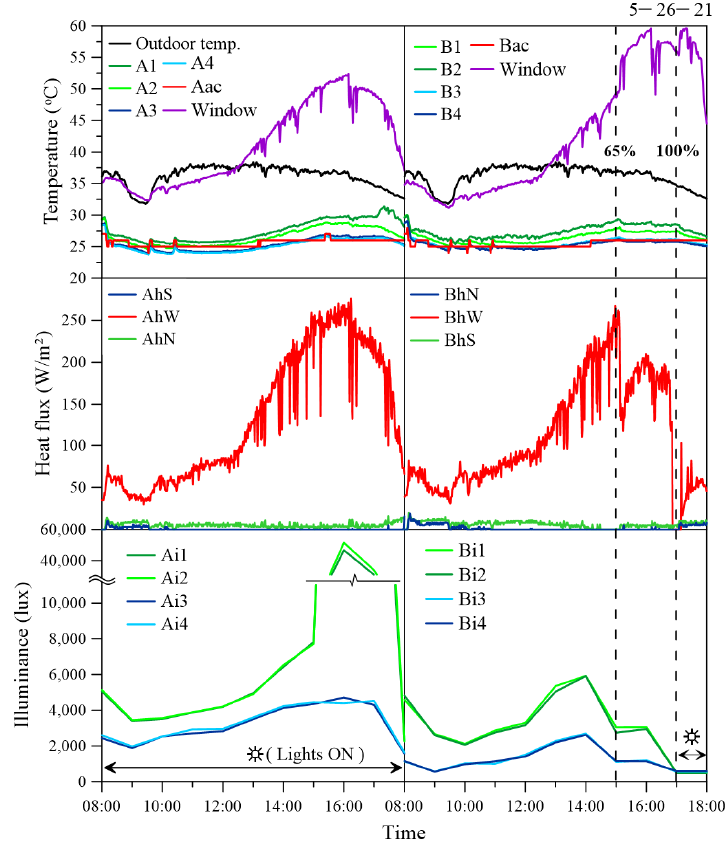
Figure 5. Indoor and outdoor environment data history on May 26th.